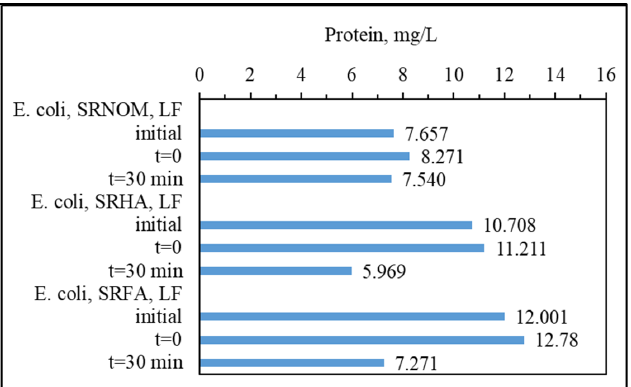
Figure 14. Protein contents of reaction matrices by the SPCI of E. coli in the presence of NOM ana- logues using LF.